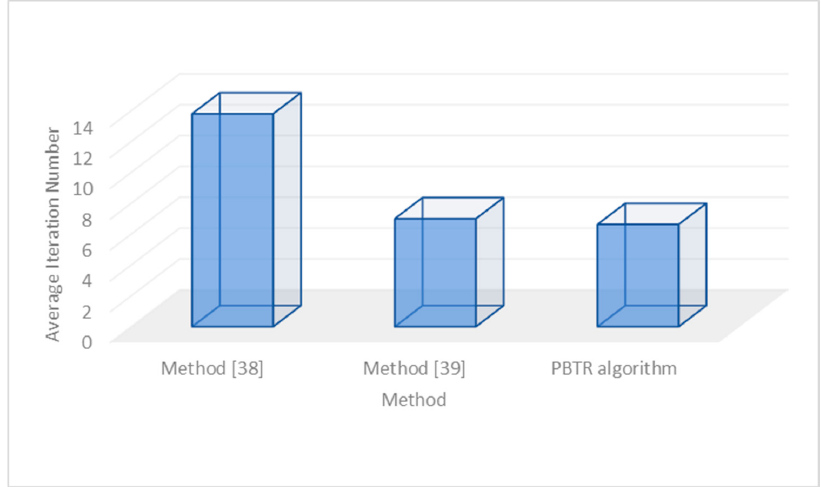
Figure 2. Average number of iterations.